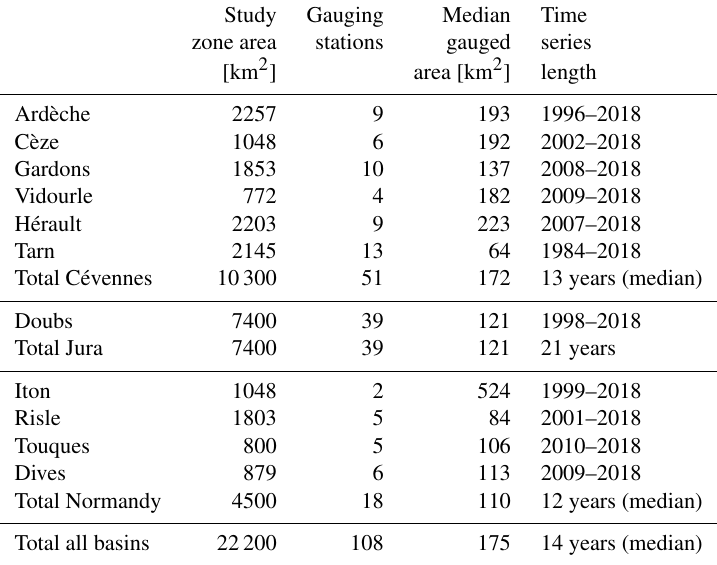
Table 1. Studied catchments and associated available data.